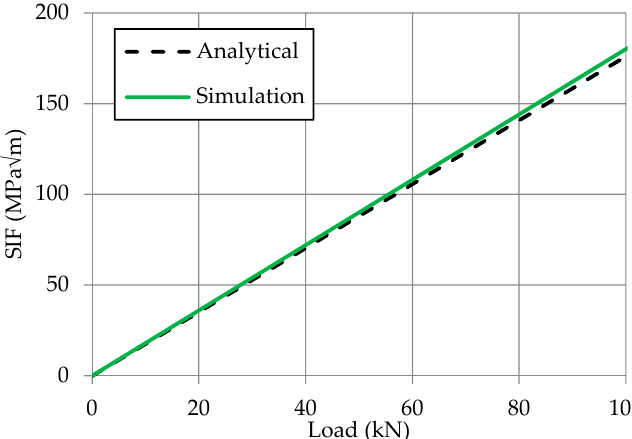
Figure 9. Stress intensity factor vs. load.